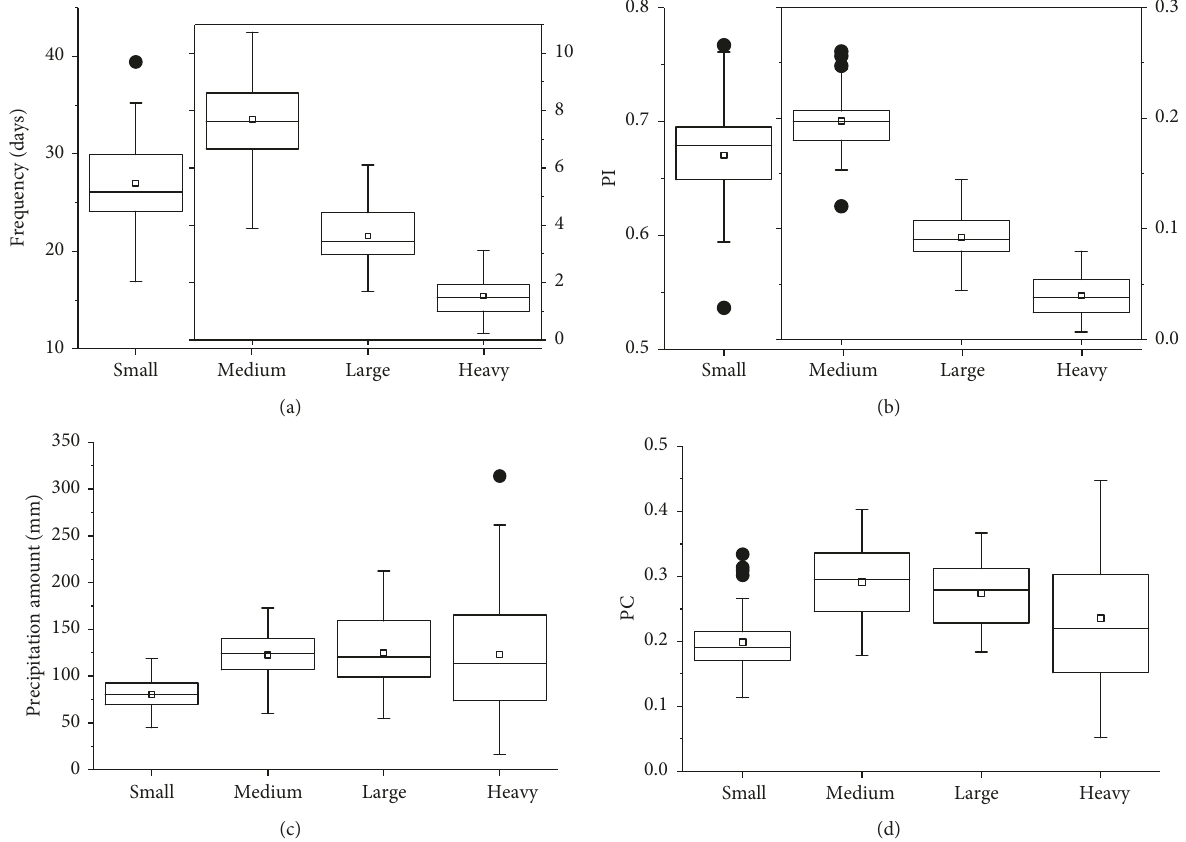
Figure 8: Box-plots of precipitation frequency (a), precipitation amount (b), precipitation incidence (c), and precipitation contribution (d) for different grades of precipitation over Beijing during 1960–2012. The boxes indicate the 25th, 50th, and 75th percentiles and the whiskers indicate the values with maximum 1.5 interquartile ranges. The hollow square indicates the mean value. The solid circle means the